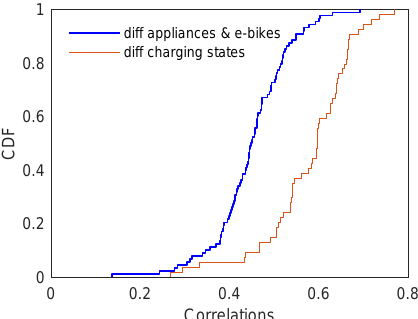
Figure 9. Blue is the CDF of 2D correlation between different appliances and e-bikes (including different charging stages). Orange is the CDF of 2D correlation between different charging states of the same